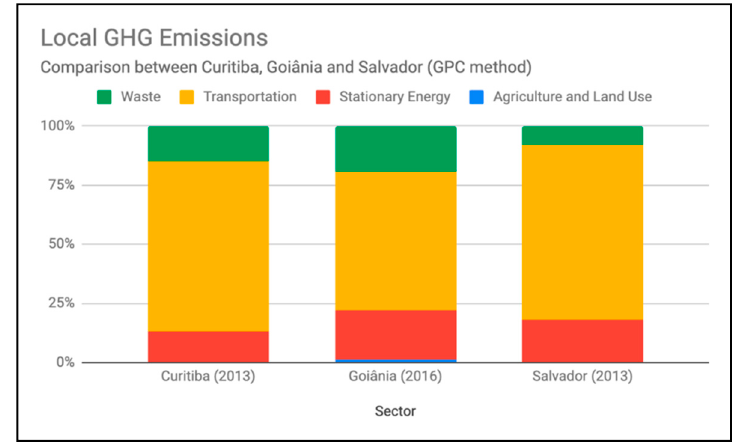
Figure 4. Local-level GHG emissions [51–53].